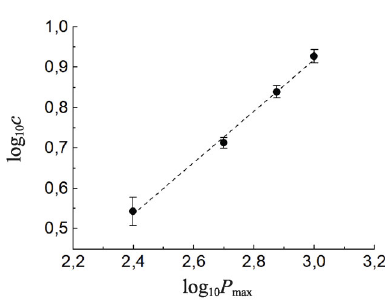
Fig. 15 Log–log plot of the crack length ( c ) vs. the maximum load P .